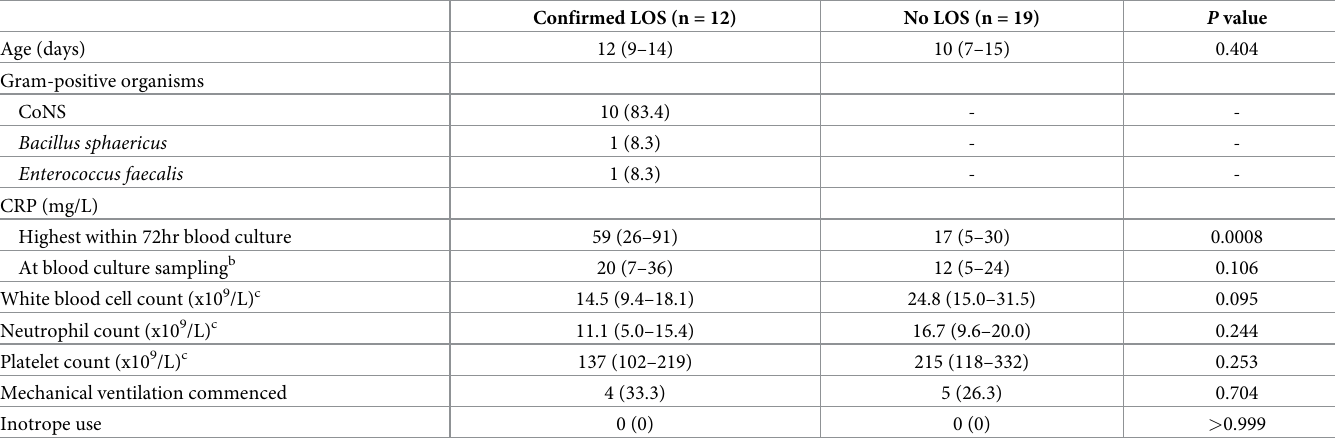
Table 2. Clinical parameters at the time of sepsis evaluation a